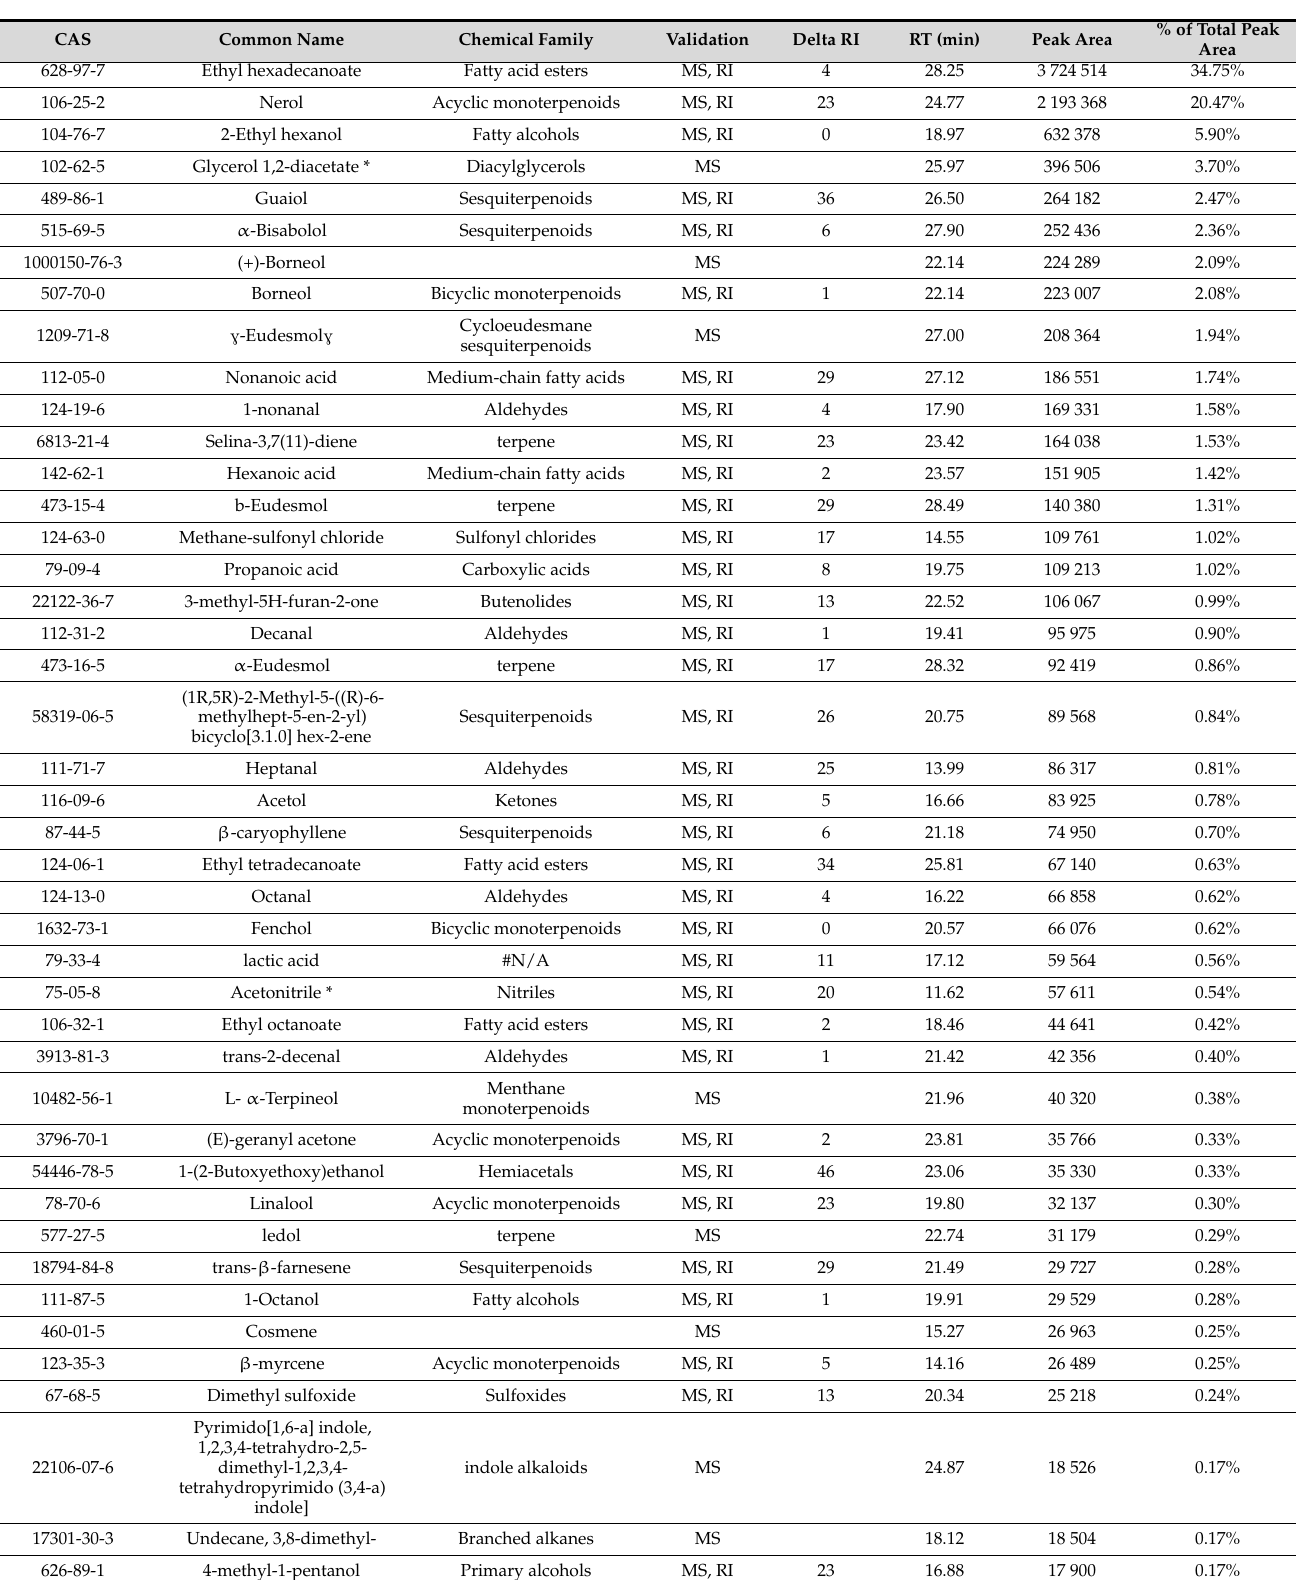
Table 2. Identification of terpenoids and other volatile compounds in the #138-10D ethanolic. Data generated by Twistaroma,